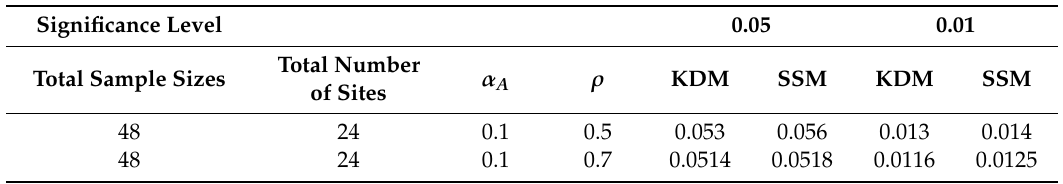
Table 1. Type I errors for both kernel distance method (KDM) and scan statistic method (SSM) based on 10,000 simulations.